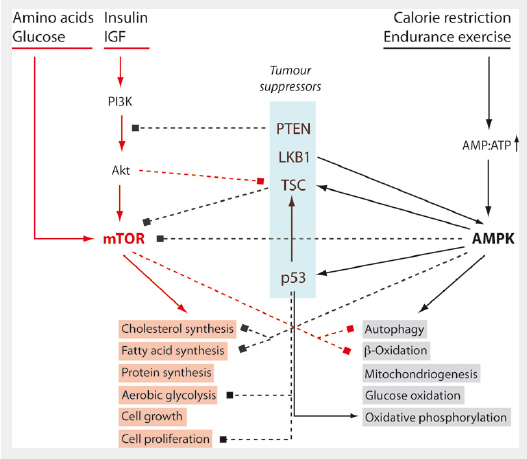
mTOR and AMPK oppose each other. Tumour enhancing pathways are coloured red, inhibitory interactions are represented by dashed lines. See text for details. AMPK: AMP-dependent kinase; IGF: insulin-like growth factor; LKB1: Serine/threonine-protein kinase 11; mTOR: mammalian target of rapamycin; PI3K: phosphoinositide 3-kinase; PTEN: phosphatase and tensin homologue; TSC: tuberous sclerosis